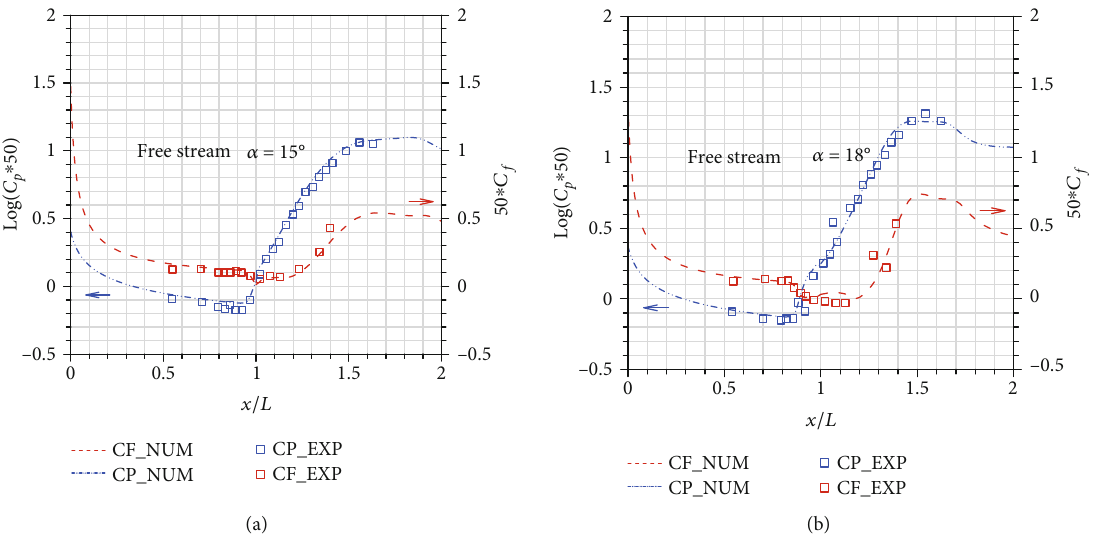
Figure 2: Comparison between pressure and skin friction for compression corner fl ows and experimental data provided by Holden: (a) ramp angle 15 ° ; (b) ramp angle 18 ° .